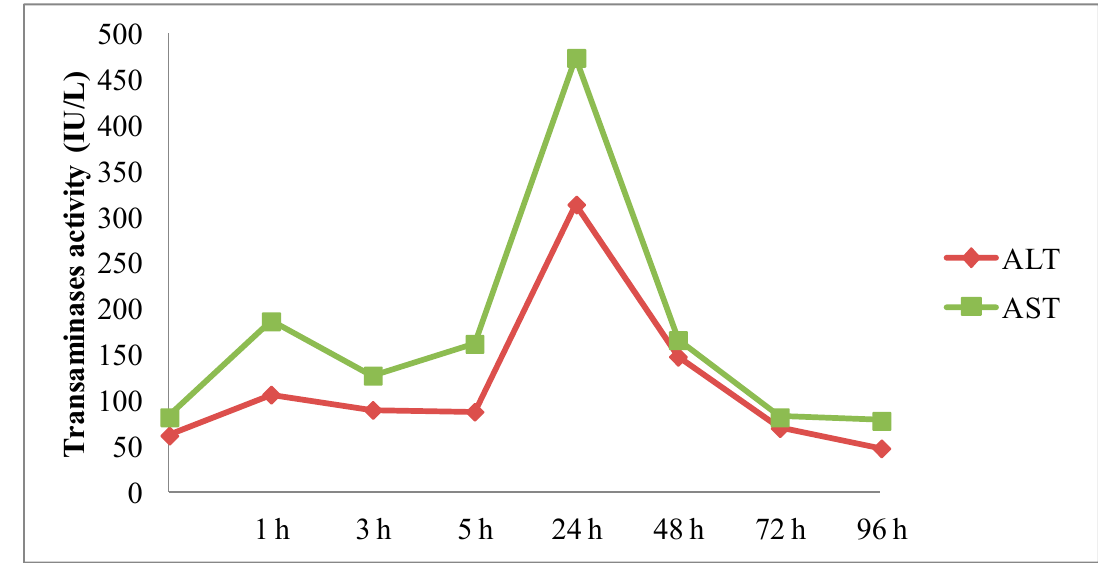
Figure 8. Kinetic of transaminase activities AST (green lines) and ALT (red lines) at different times following FL1C + DSPE-PEG 2000 /pGM144-based lipoplex administration. Results were based on one mouse per time, and expressed as IU/L.